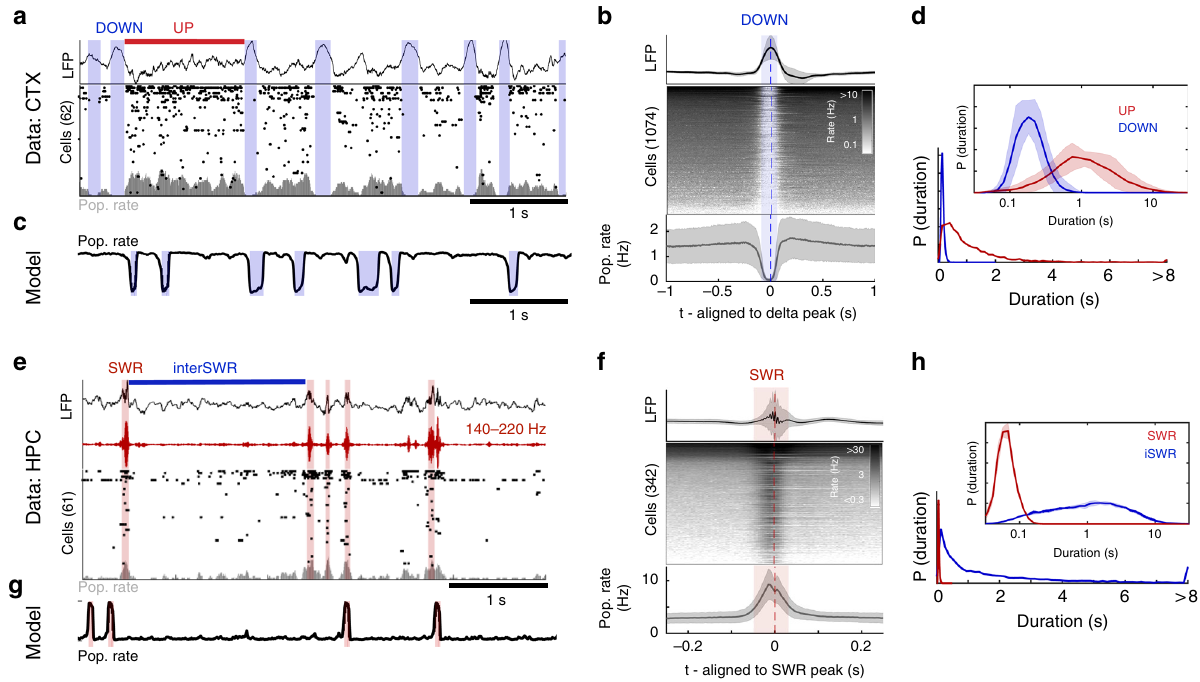
Fig. 1 Neocortical UP/DOWN and hippocampal SWR dynamics during NREM sleep. a A sample of data from rat mPFC during NREM sleep. Data were collected using high-density silicon probes 19 . LFP and spike times from cortical neurons were extracted as reported previously (see Methods). Neocortical slow waves are coincident with population-wide non-spiking DOWN states, which alternate with UP states of longer duration. b Peri-event time histogram aligned to delta peaks for the LFP (top), all recorded cells (middle), and population rate (bottom). c Simulation of the model (Eqns 1 – 2). Parameters determined by matching in vivo and simulated UP/DOWN state dwell times, as described in section: ‘ Neocortex is in an Excitable UP regime during NREM sleep ’ . d UP/DOWN state dwell time distribution (bottom) in linear (example recording) and logarithmic scale. e A sample of data from rat CA1 (HPC) during NREM sleep 65 . Detected sharp wave-ripples (SWR) indicated with red. f Peri-event time histogram aligned to SWR peaks for the LFP (top), all recorded cells (middle), and population rate (bottom). g Simulated r-a model with the best-matching parameters, as described in section: ‘ Hippocampus is in an Excitable DOWN regime during NREM sleep ’ . h SWR and inter-SWR duration distributions in linear (example recording) and logarithmic scale. All shaded lines re fl ect mean ± standard deviation over